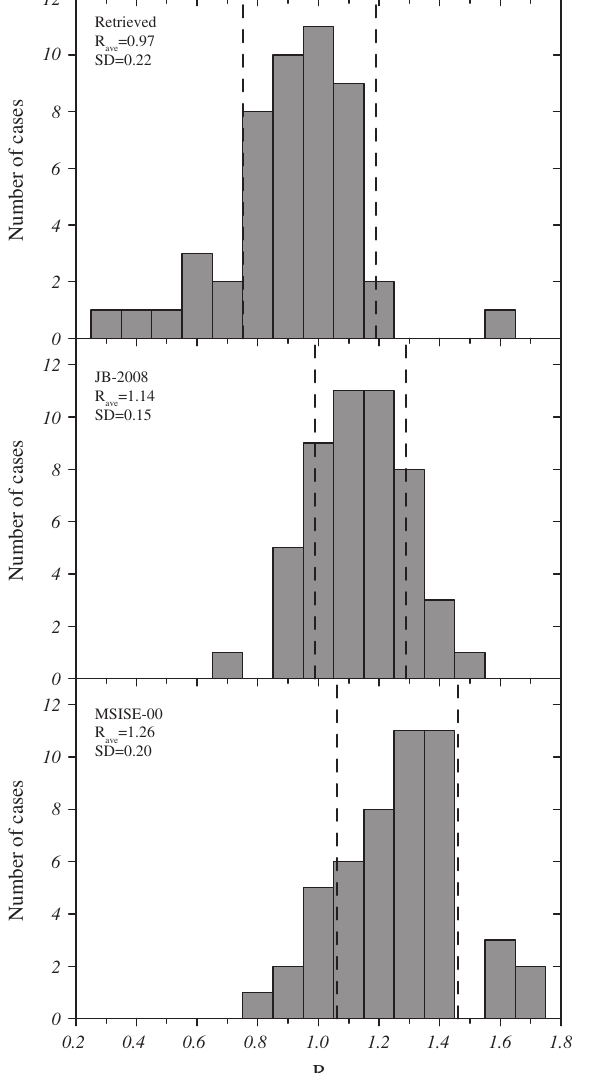
Fig. 2. Retrieved and modeled neutral gas densities from Table A1 are given vs. the observed values. Note that the retrieved densities are more centered with respect to the observed ones while modeled values are biased overestimating the observations. MRD and bias are given for a